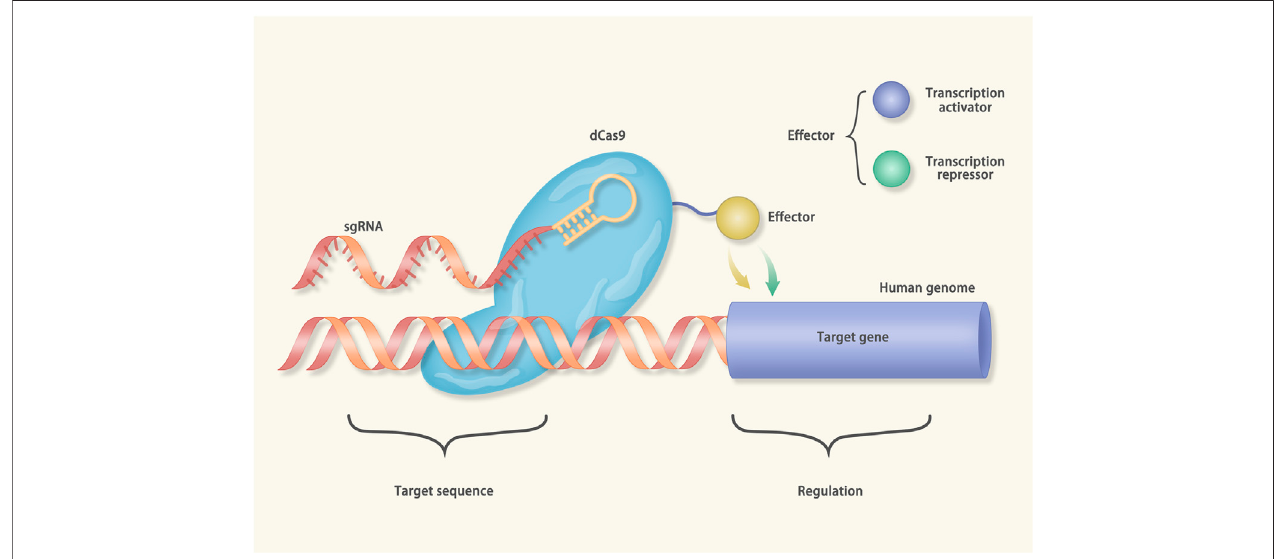
FIGURE 4 | Mechanisms of CRISPR interference (CRISPRi) and CRISPR activation (CRISPRa): The cas protein in the CRISPRi/a is catalytically inactivated (called dcas9). In the CRISPRi, the dcas9 connects with transcriptional suppressors, such as Kruppel associated box (KRAB). Under the guidance of gRNA, the dcas9-KRAB fusion protein binds to the transcription start site (TSS) of the target gene and inhibits transcription. On the contrary, the dcas9 of the CRISPRa is equipped with the transcriptional activator to a given TSS.